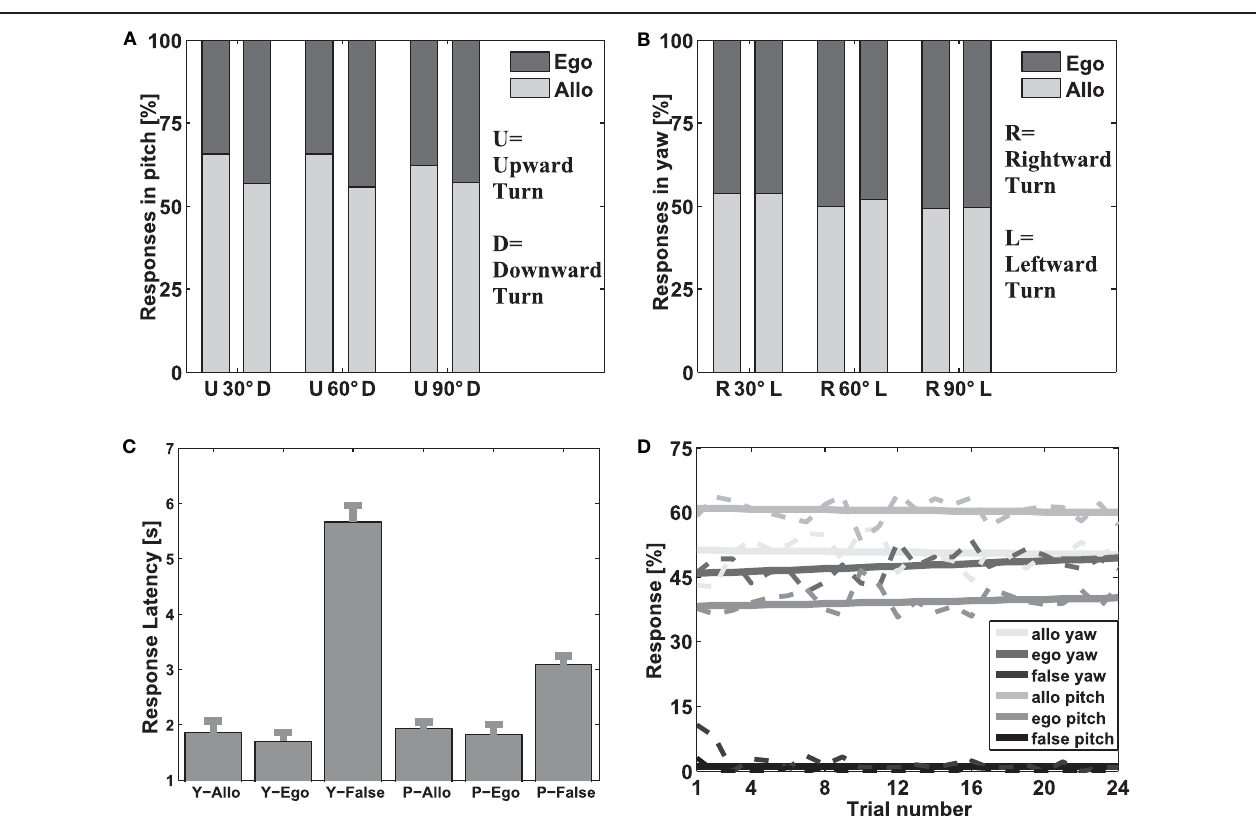
FIGURE 2 | Investigation of response types. (A,B) Ratio of allocentric vs. egocentric responses for all passages in pitch (panel A ) and yaw (panel B ). In both figures the y-axes displays the relative amount of allocentric vs. egocentric responses. The x-axes indicate the different passages in both yaw and pitch. The dark gray bars indicate the amount of egocentric responses; the light gray bars indicate the amount of allocentric responses. (C) Response times for all responses types. The y-axis shows the response times in seconds from stimulus onset (appearance of the arrows) until one arrow was chosen (mouse click). The